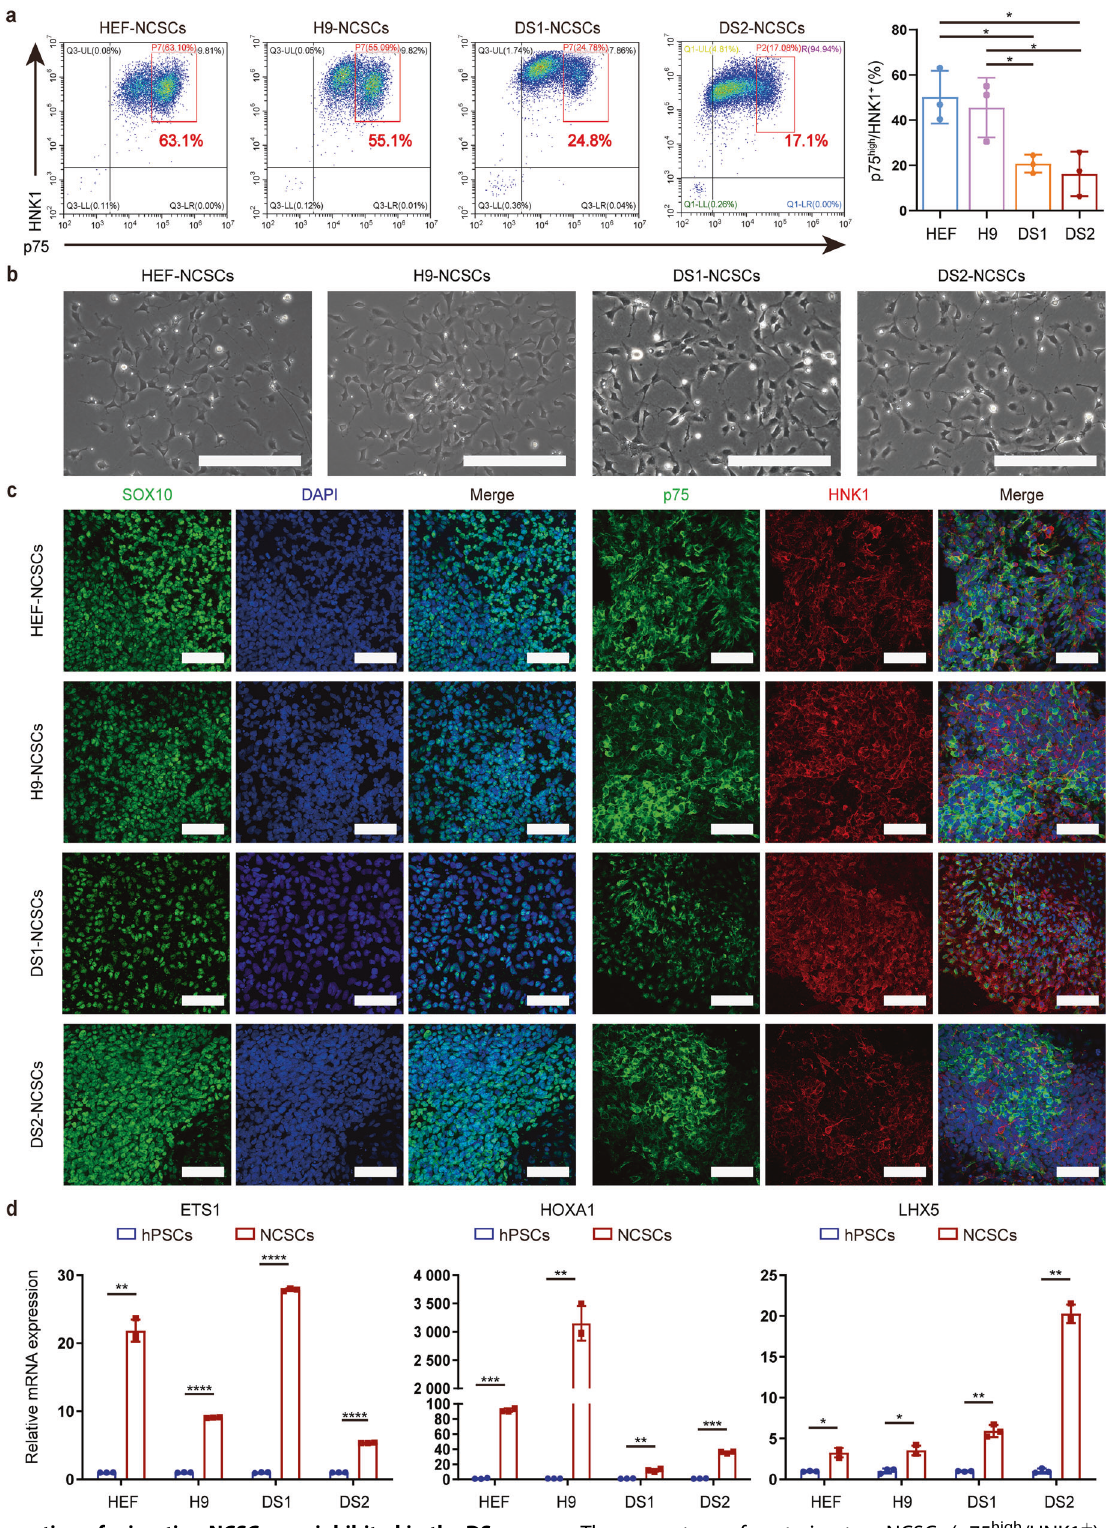
Fig. 3 Generation of migrating NCSCs was inhibited in the DS group. a The percentage of postmigratory NCSCs (p75 high /HNK1 + ) generated by monolayer protocol was detected by FACS. b FACS-enriched NCSCs maintained typical neural crest morphology during in vitro culture. Scale bar: 250 μ m. c The expression of the neural crest-speci fi c markers (SOX10, p75, HNK1) in isolated NCSCs was detected by immunostaining. Scale bar: 100 μ m. d The expression of cranial neural crest-speci fi c markers (ETS1, HOXA1, and LHX5) in NCSCs was detected by qPCR. Data are presented as the mean ± SD of three independent experiments. n = 3. * P < 0.05, ** P < 0.01, *** P < 0.001, **** P < 0.0001, two- tailed unpaired Student ’ s t test.